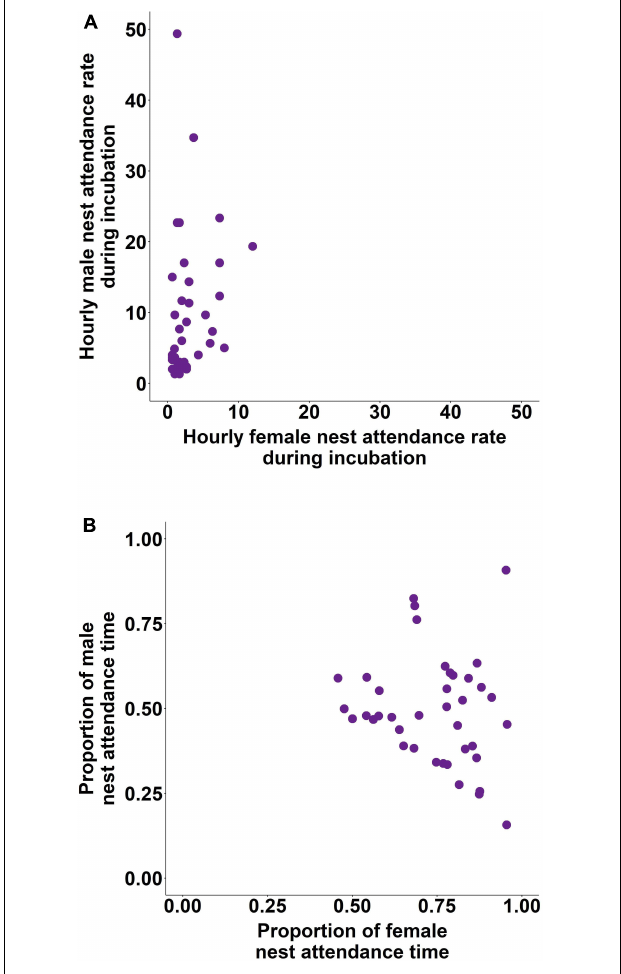
FIGURE 2 | Hourly nest attendance rate (A) and proportion of 3 h observation time spent attending the nest (B) in incubating zebra finch pairs.